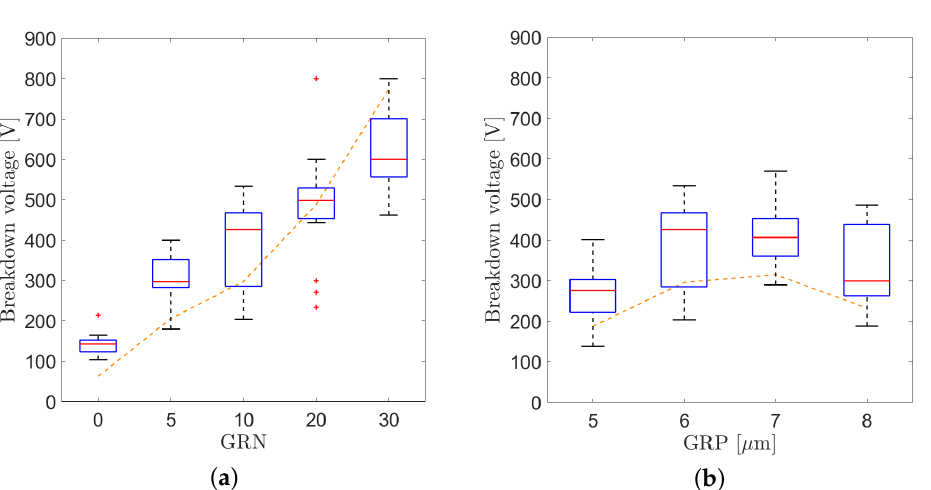
Figure 12. ( a ) Box plot of the breakdown voltages measured on a set of backside diodes from different wafers and breakdown voltages extracted from the simulations (dashed orange line) as a function of the guard ring number for a pitch of 6 µ m. ( b ) Box plot of the breakdown voltages measured on backside diodes with 10 guard rings and breakdown voltages extracted from the simulations (dashed orange line) as a function of the guard ring